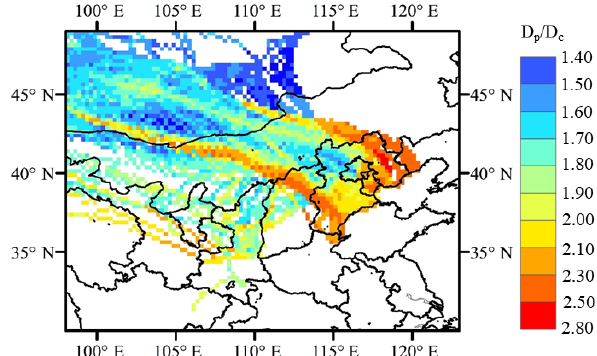
Figure 7. Aging degree (i.e., D p /D c ) of BC particles as they are transported to the receptor site (40 ◦ 00 (cid:48) 17 (cid:48)(cid:48) N, 116 ◦ 19 (cid:48) 34 (cid:48)(cid:48) E) from emission origins (0 . 25 ◦ × 0 . 25 ◦ ) during the BJNOV2014 campaign period. The gridded D p /D c ratio was calculated by Eq.